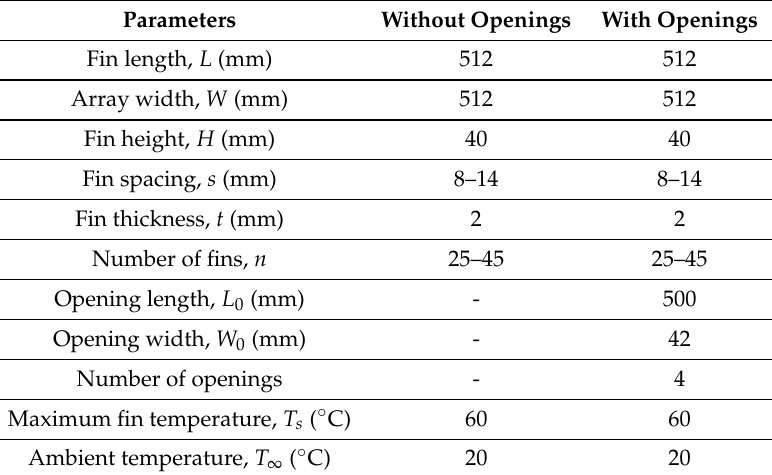
Figure 4. The new heat sink design with openings in the base for the prototype LED grow light. Table 2. Design parameters of the new heat